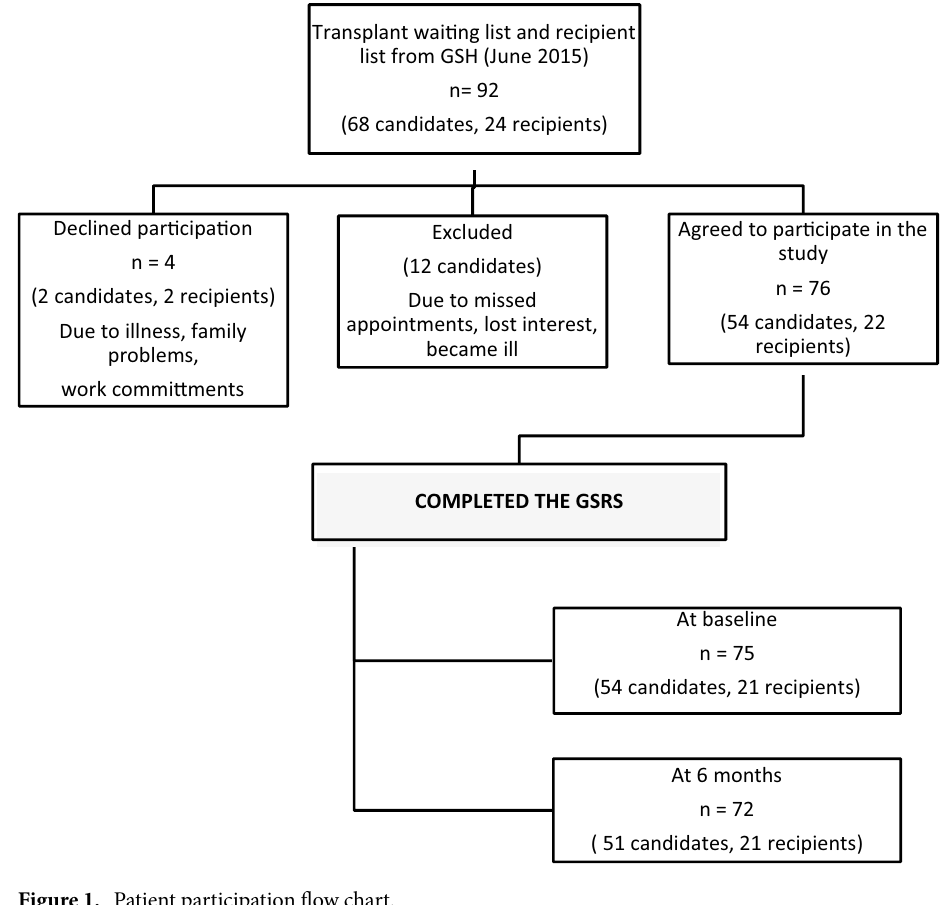
Figure 1. Patient participation flow